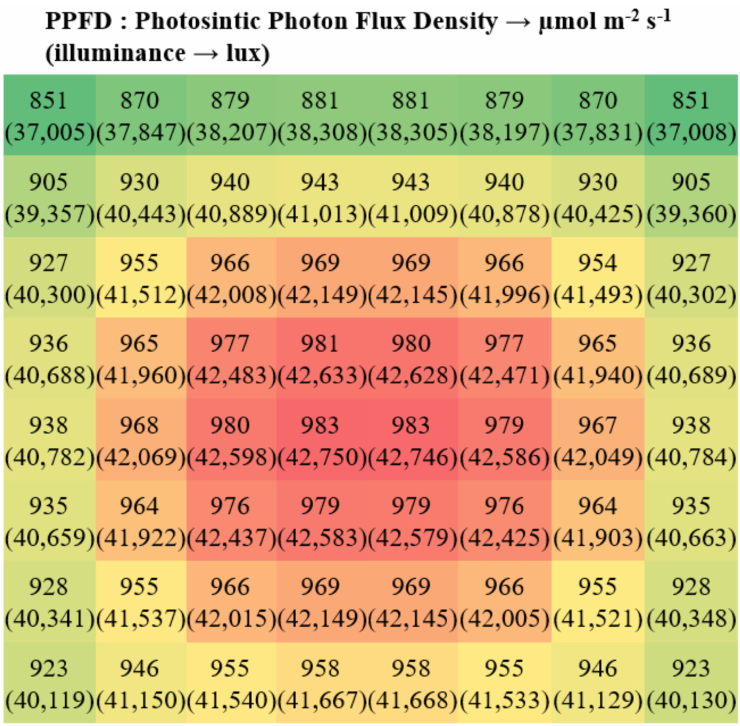
Figure 15. PPFD (illuminance) map of Case 2-3.